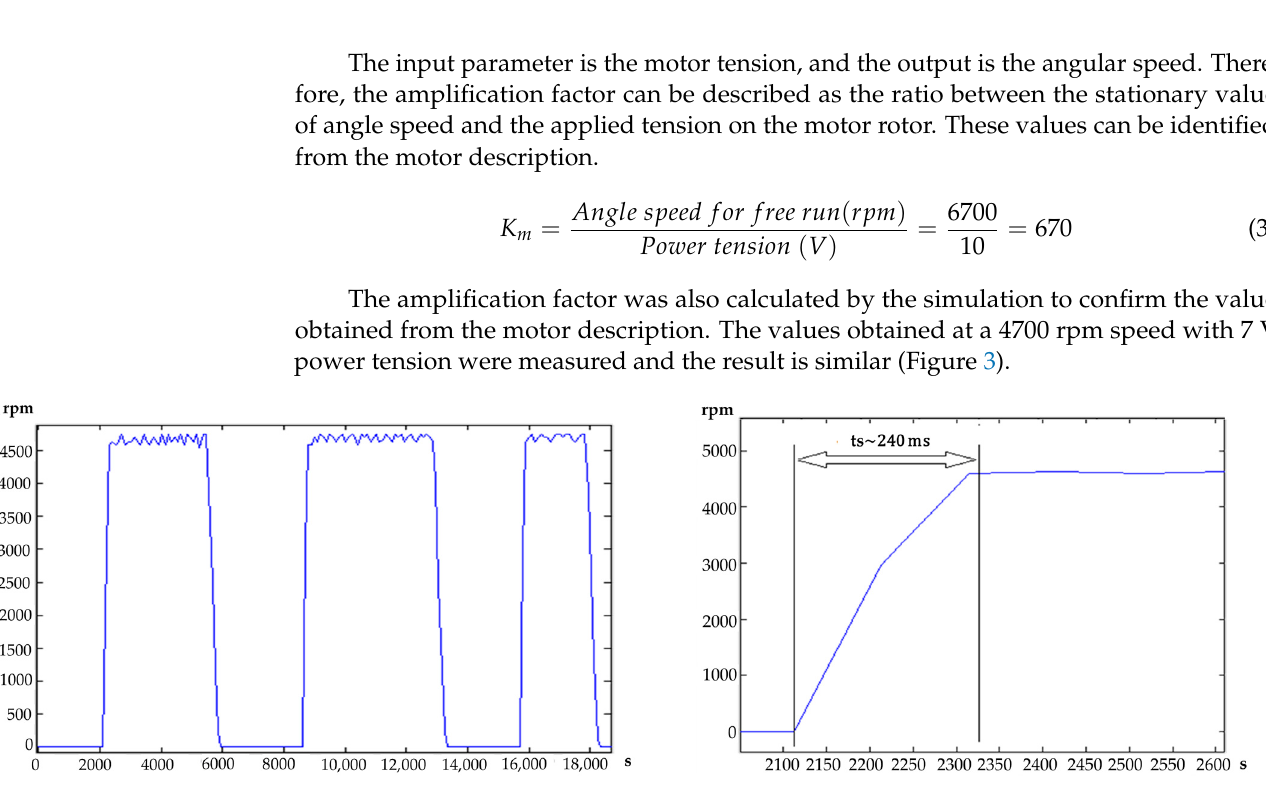
Figure 3. Motor amplification factor simulation.